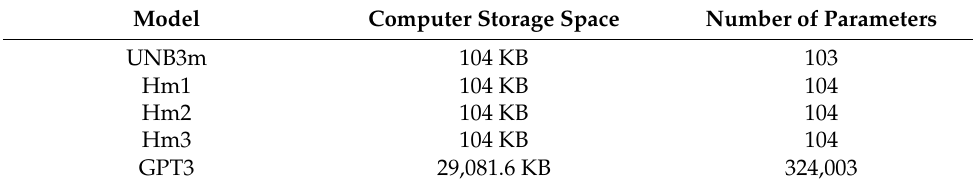
Table 4. The computer storage space and the number of parameters for each model.